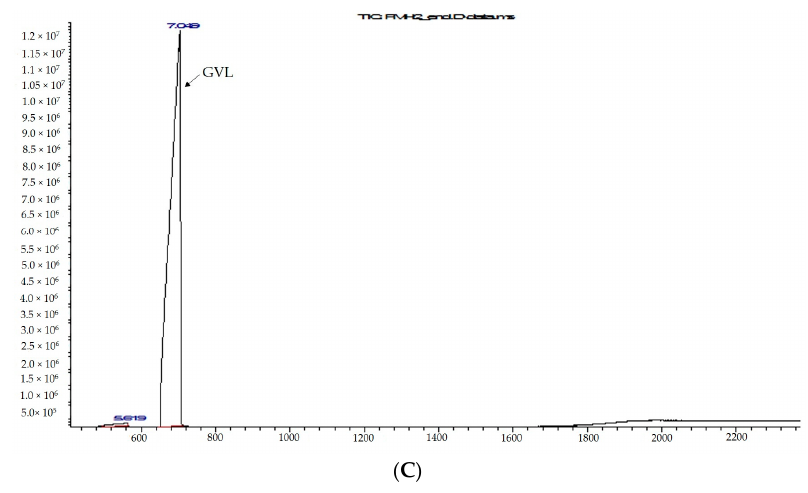
Figure 3. ( A ) 1 H-NMR of the organic phase after the precipitation of lignin; ( B ) 1 H-NMR of the same solution after hydrogenation; ( C ) GC-MS of the same solution after hydrogenation.